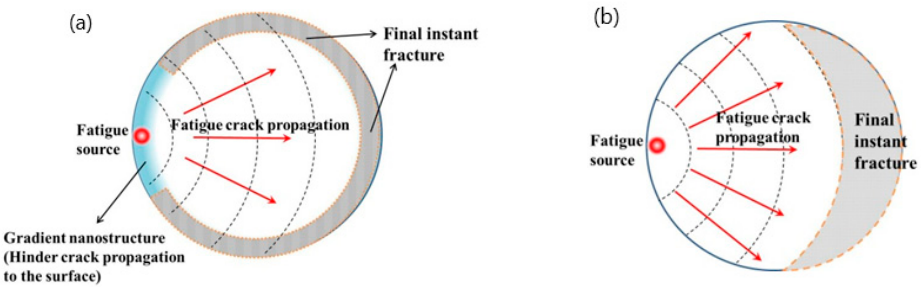
Figure 10. Schematic illustration of fatigue crack initiation, propagation, and final instant fracture, and the effect of SNG surface layer on crack propagation ( a ) SMGTed Zr-4, ( b ) CG